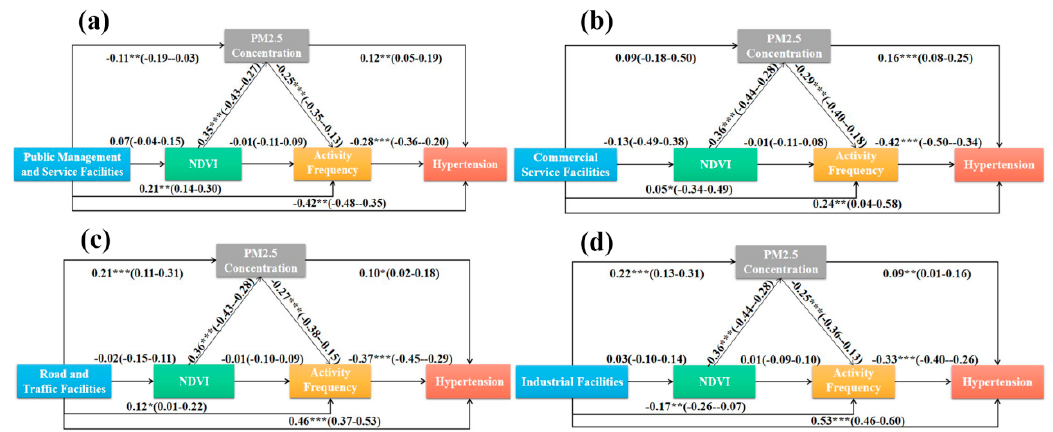
Figure 4. Conceptual diagram of serial mediation models linking built environment with hyperten-